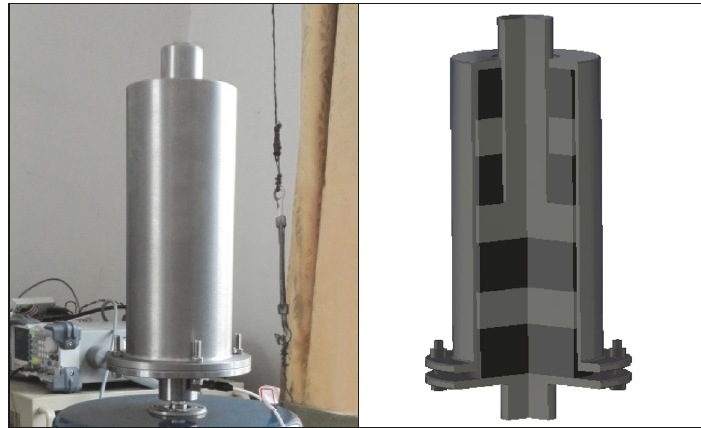
Figure 5: Image and cutaway view of a sample periodic